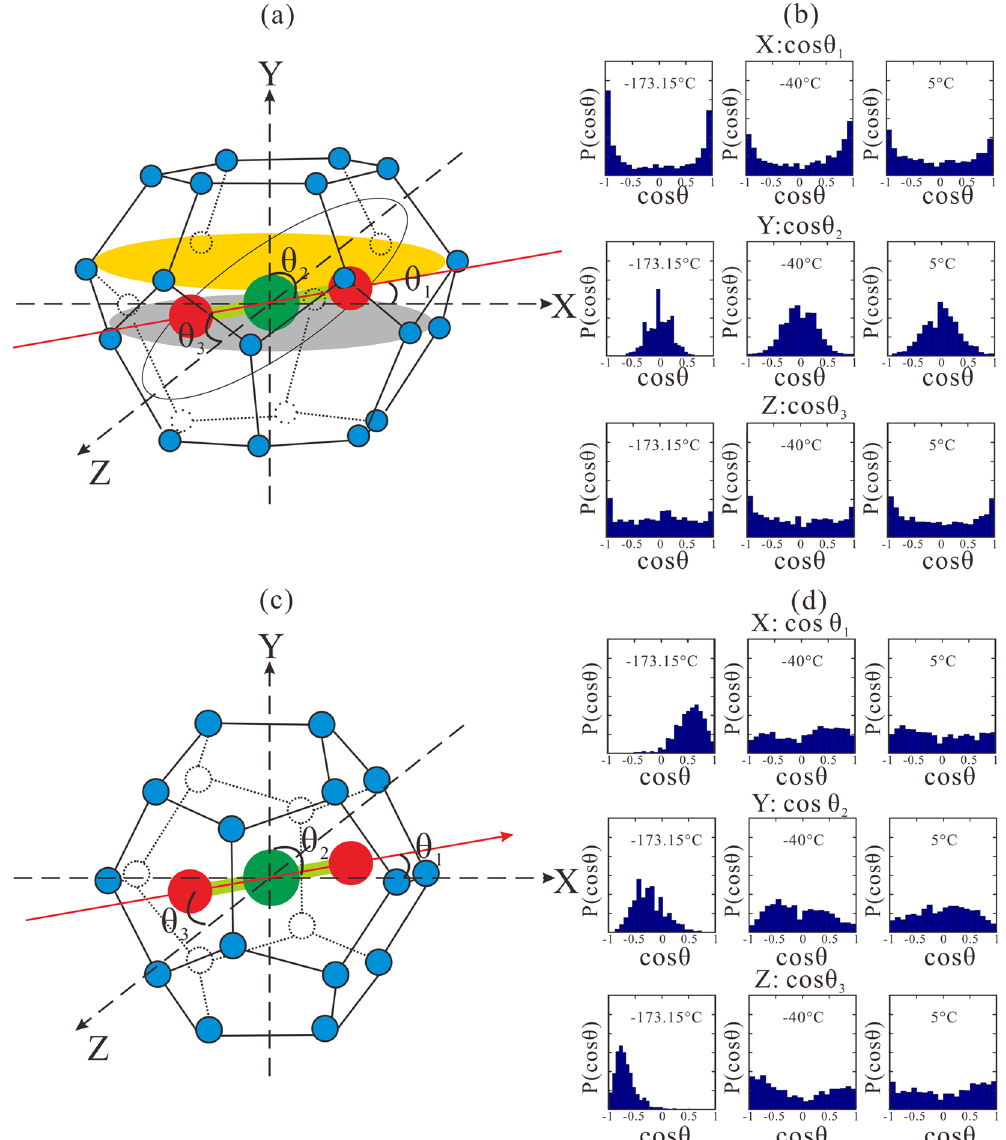
Figure 4. Kinetic behavior of CO 2 molecules residing in L-cage (No. 1) and S-cage (No. 7), the equatorial plane in L-cage is perpendicular to Y axis. ( a , c ) Schematic graph of rotational motion of CO 2 molecule. Red straight line represents the long axis of the CO 2 molecule. Blue solid circles denote water molecules on the vertices of the cage. Red solid circles (oxygen atoms) and large green solid circle (carbon atom) comprise CO 2 molecule. ( b , d ) Distribution of rotational correlation coefficients θ (cos ) in different directions for CO 2 molecules shown in ( a , c